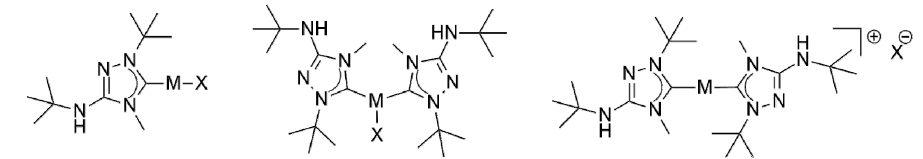
Figure 2. Plausible structures of the coinage metal complexes of the present study. ( Left ) “1:1 complexes”